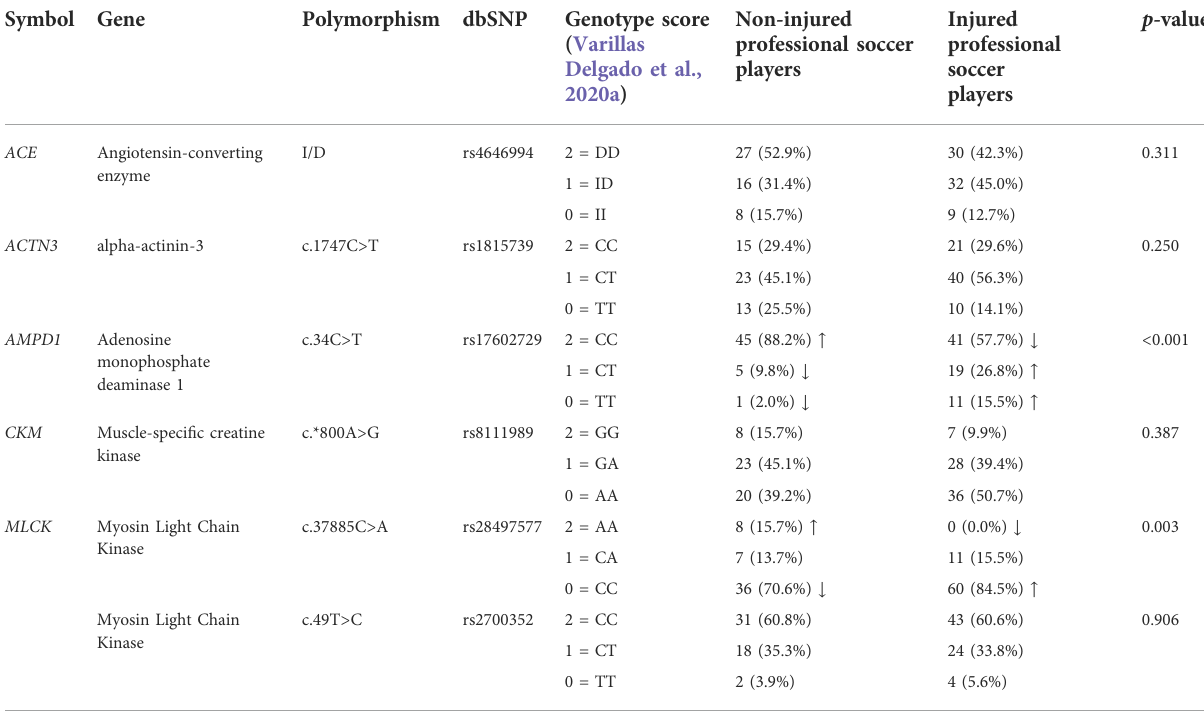
TABLE 5 Genotype distribution in non-injured and injured professional soccer players for muscle injuries polymorphisms.